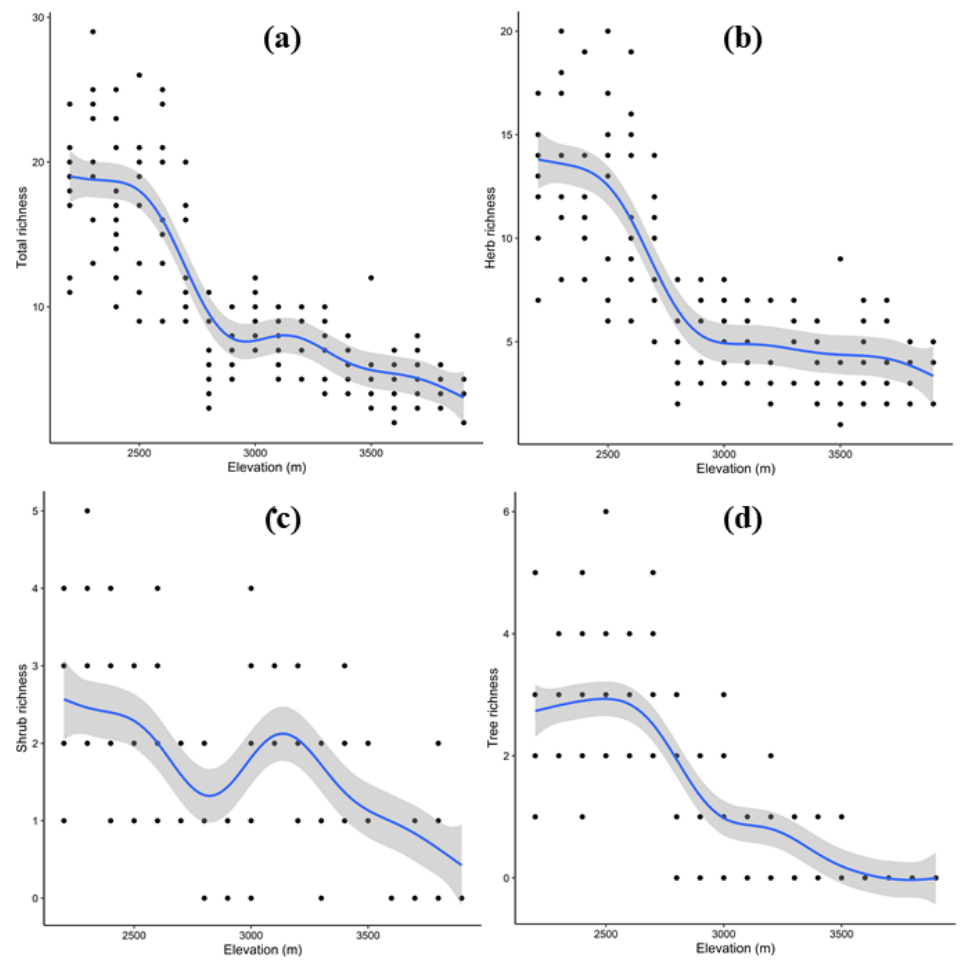
Figure 6. Relationship between elevation and plant richness patterns for total ( a ), herb ( b ), shrub ( c ) and tree ( d ) recorded at 100 m elevation belts. Shown are the best-fitted regression splines from generalized additive model (solid blue line), standard errors (grey shadings) and observations (black dots).